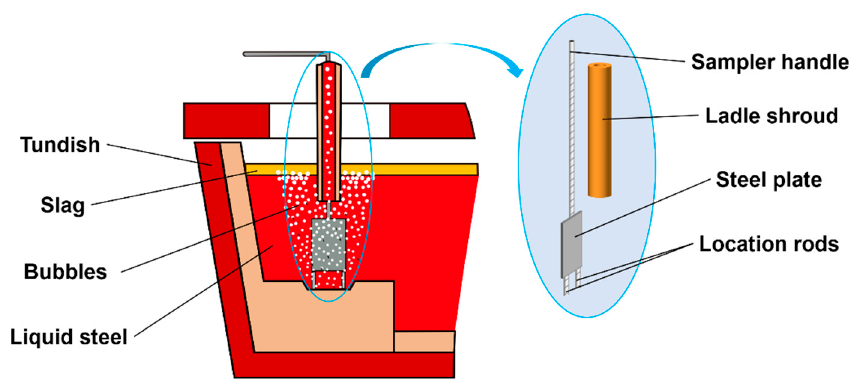
Figure 2. Sampler used for the method of “cold steel plate dipping”.